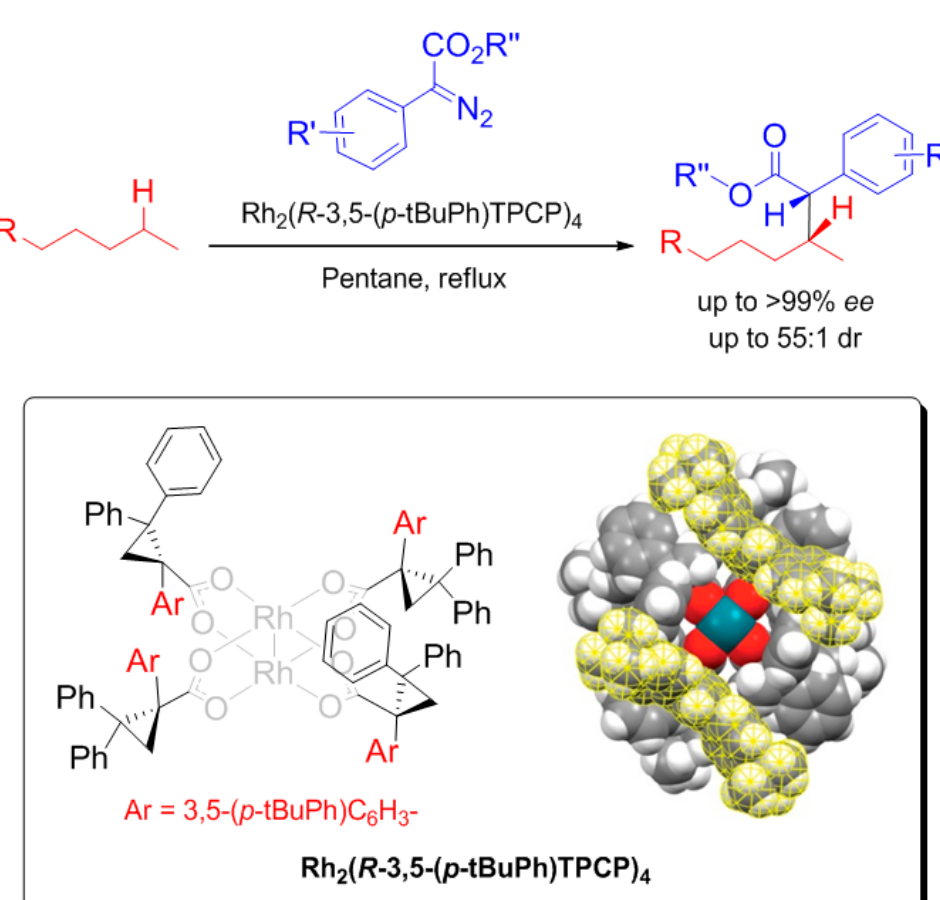
Scheme 4. Rh 2 ( R -3,5-di( p -tBuPh)TPCP) 4 -catalysed C-H functionalization of pentane and